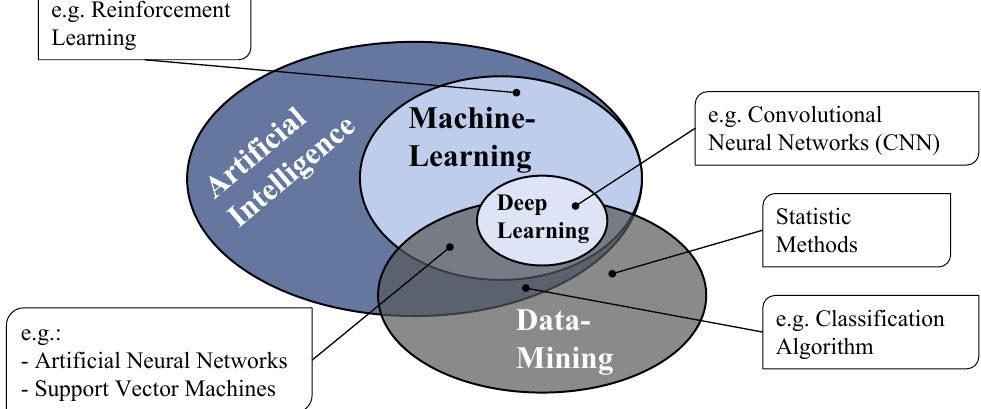
Figure 1. Categorisation of the terms Machine Learning and Data Mining according to